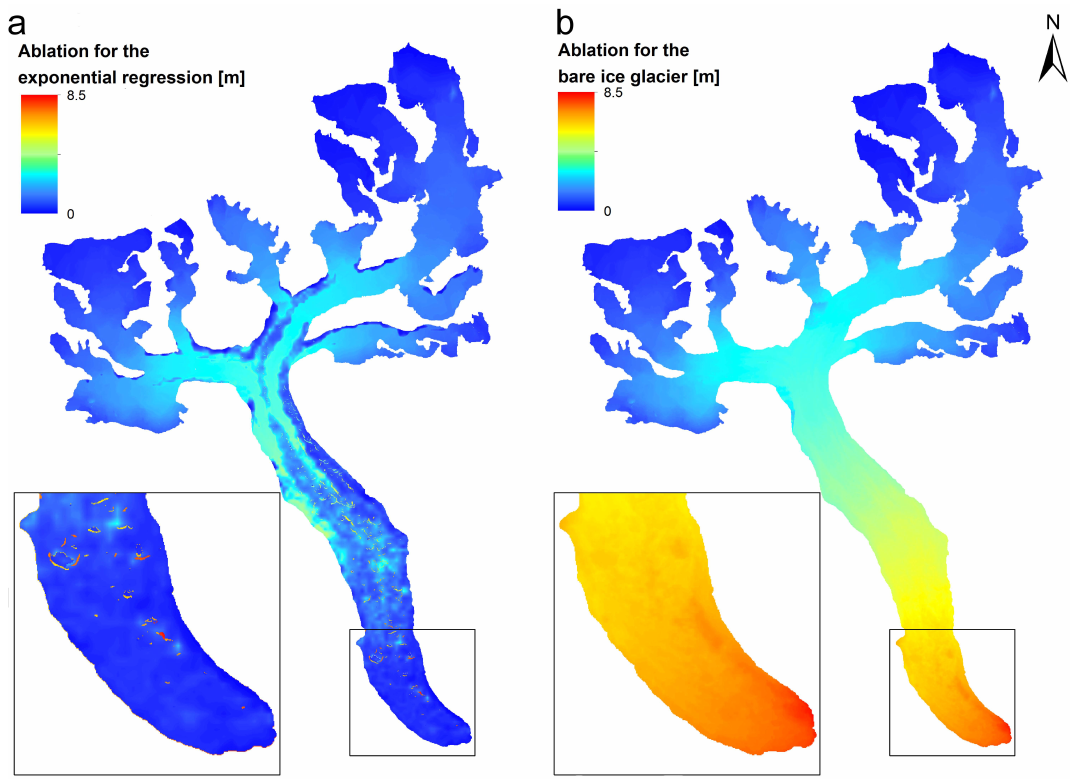
Fig. 9. Distribution of ice ablation for the time span of 1 May 2010 to 31 October 2010, including a zoomed section of the terminus. (a) Debris covered Koxkar Glacier using the exponential regression; (b) ablation if no debris were present on the glacier surface.